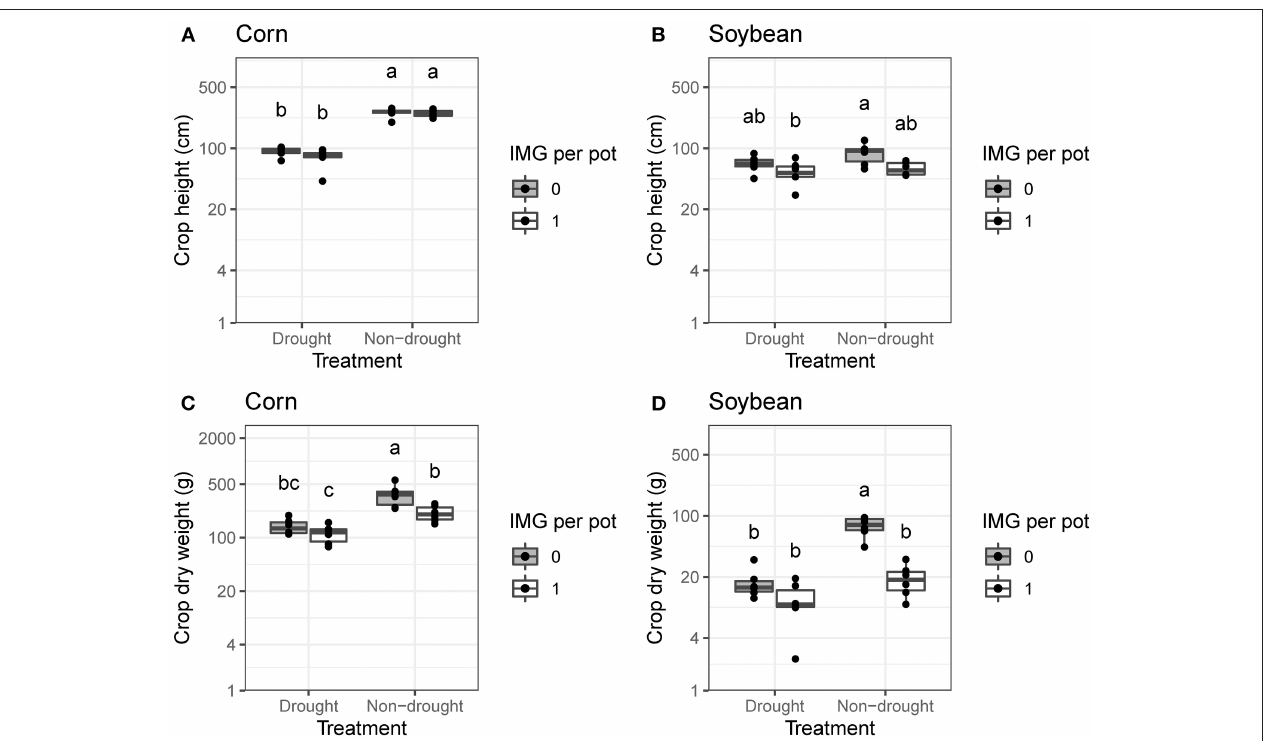
FIGURE 1 | Effects of drought treatment and ivyleaf morningglory (IMG) on crop height and biomass under greenhouse conditions. Pots with a single crop plant (1R0W) are compared to pots with one crop plant and one IMG plant (1R1W). Data are presented for (A) corn height, (B) soybean height, (C) corn biomass, and (D) soybean biomass. Within crop species and growth parameter, treatments labeled with the same letter are not significantly different according to Tukey’s HSD test ( α =